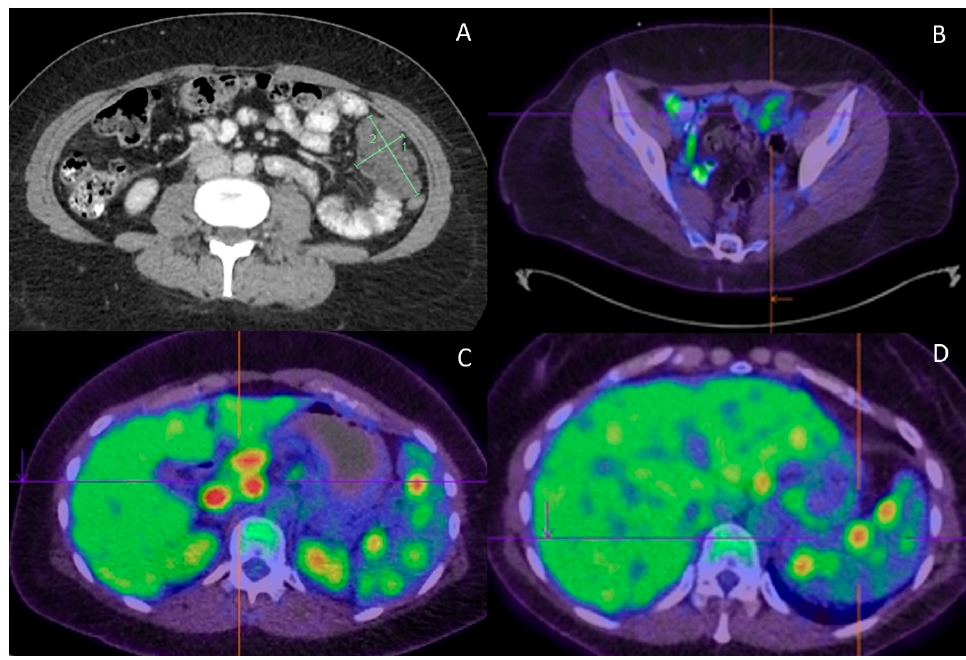
Figure 2. Radiological features. ( A ) Progress CT at completion of adjuvant chemotherapy found new peritoneal lesions; ( B ) Peritoneal lesions demonstrate only low FDG uptake (SUVmax of 3.9); ( C ) On the contrary, portal hepatis/peripancreatic lymphadenopathy is highly FDG avid (SUVmax of 13.3); ( D ) High FDG uptake (SUVmax of 9.3) is also observed in the splenic lesions. Her imaging and pathology were reviewed in our Gynecological Oncology multidis- ciplinary team (MDT) meeting. The peritoneal masses with low FDG uptake were con- sistent with growth teratoma syndrome (GTS). The hypermetabolic lymphadenopathy